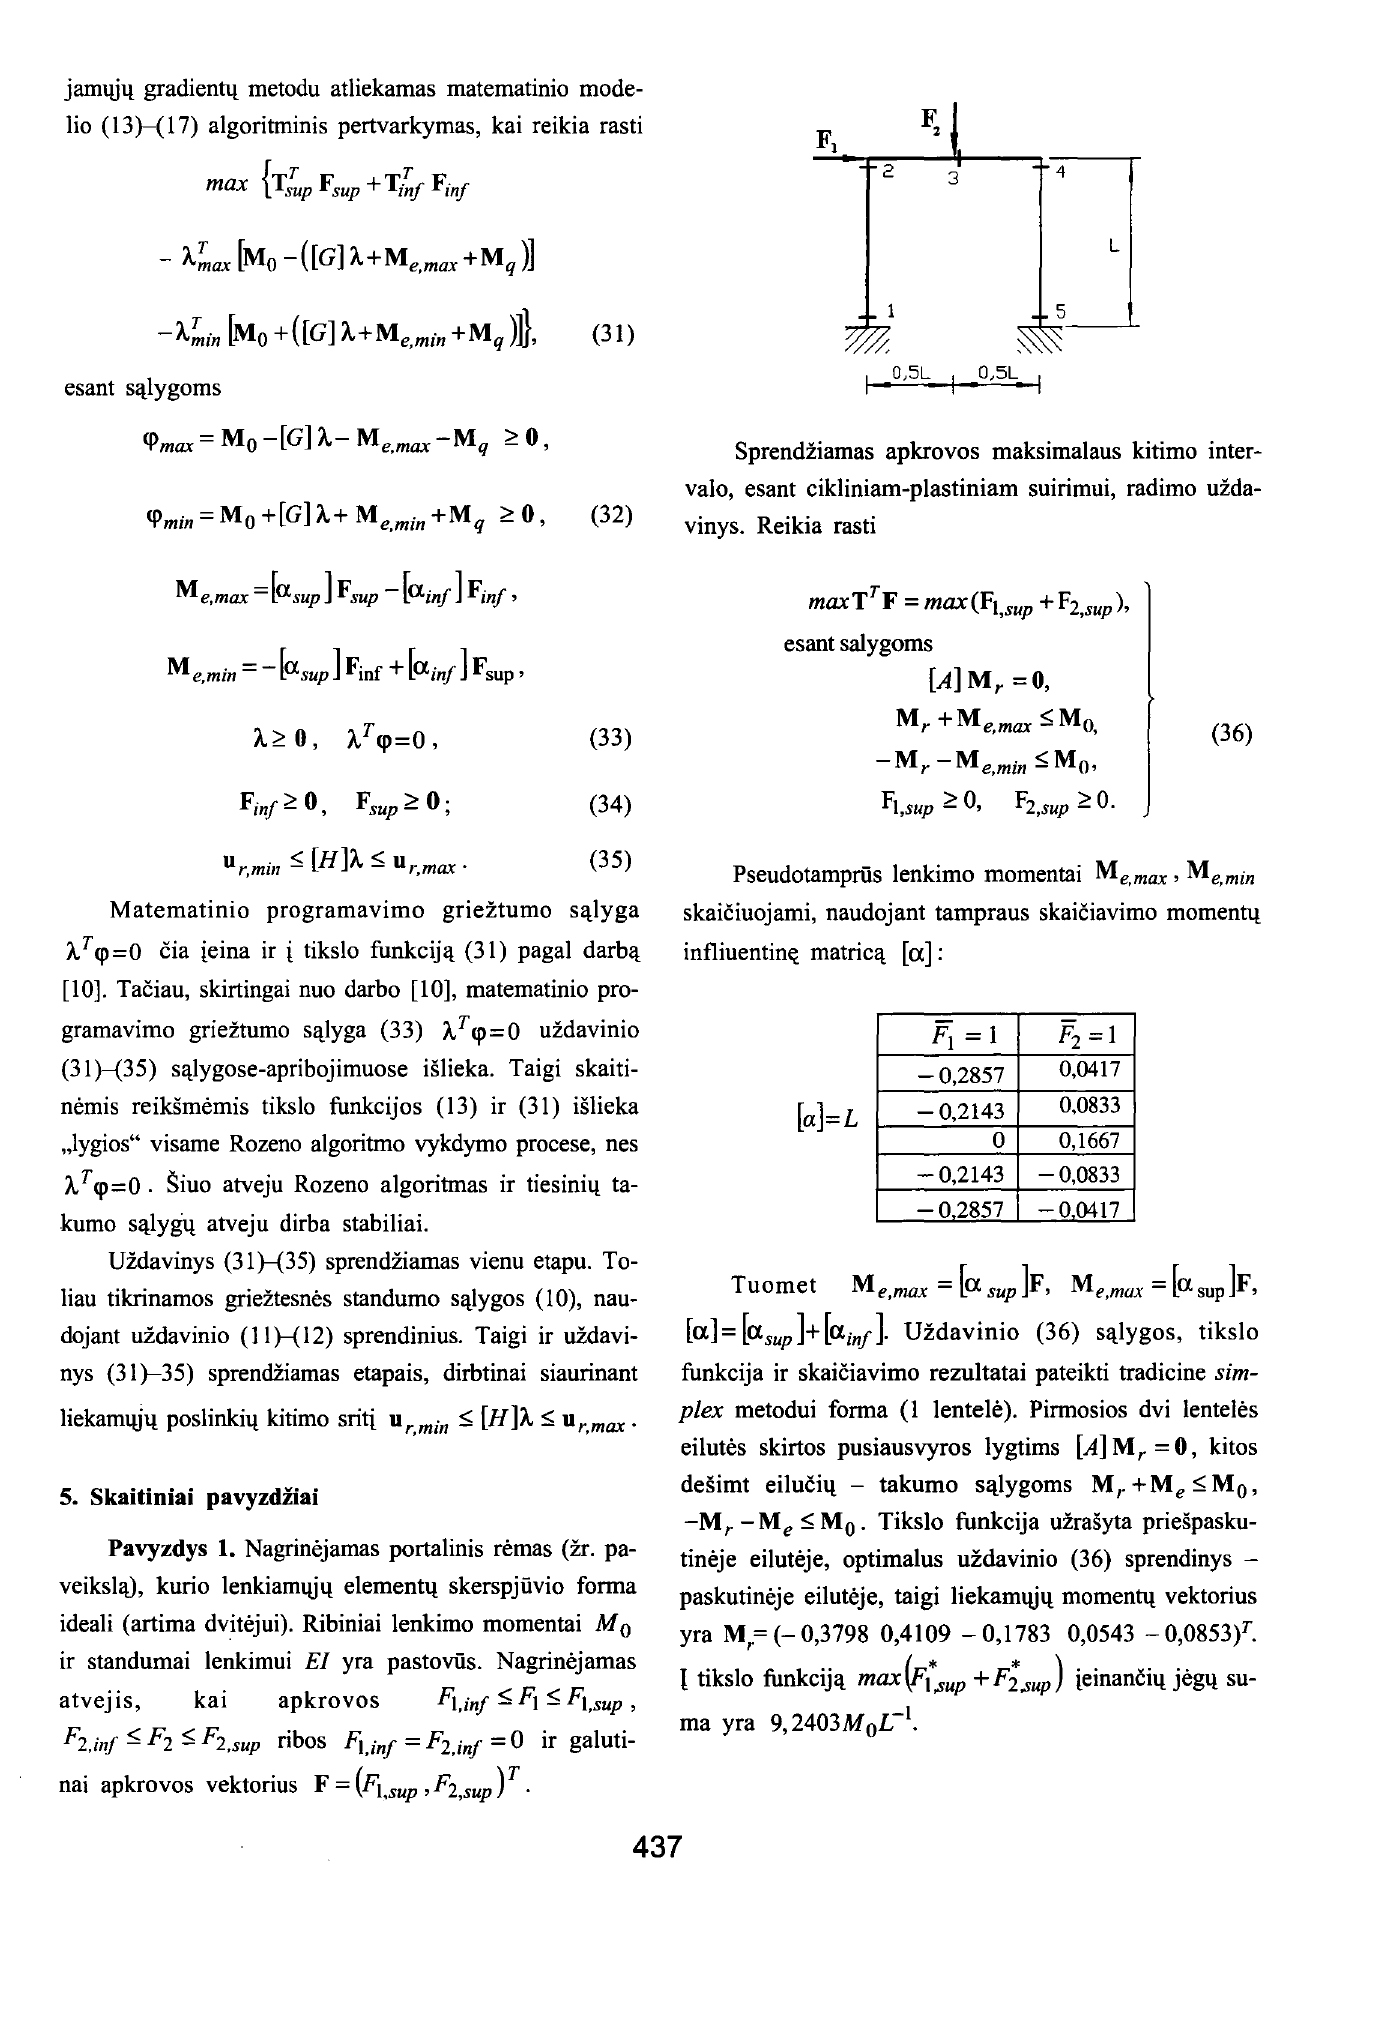
Pseudotampriis 1enkimo momentai Me,max,